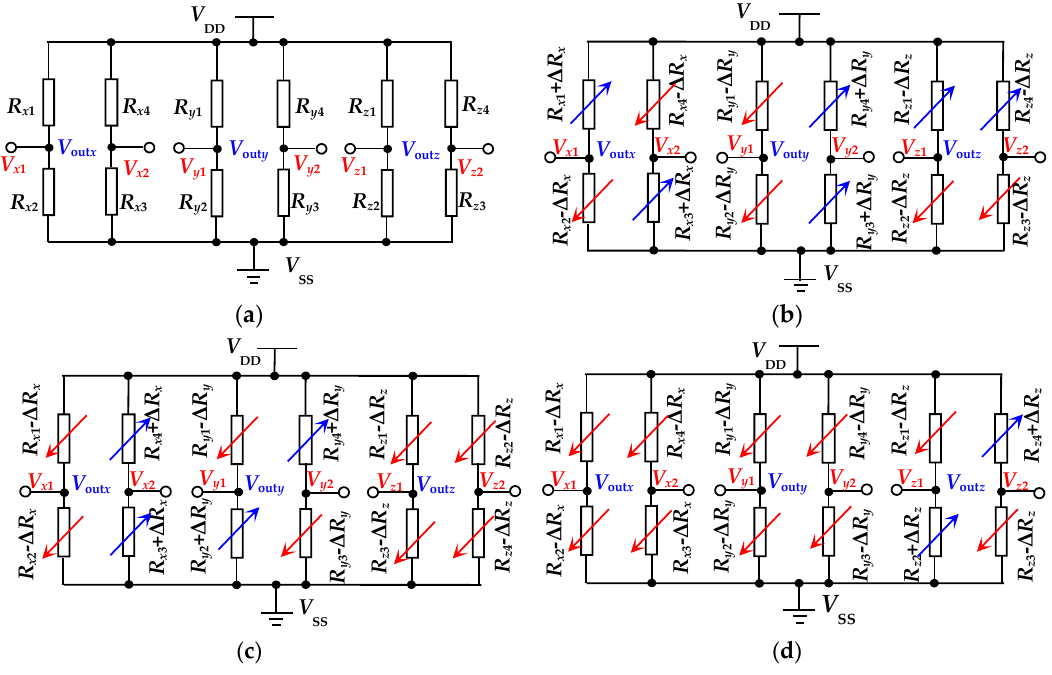
Figure 3. Equivalent circuit of the SOI three-axis acceleration sensor: ( a ) a x = a y = a z = 0 g; ( b ) a = a x ; ( c ) a = a y ; and ( d ) a = a z .